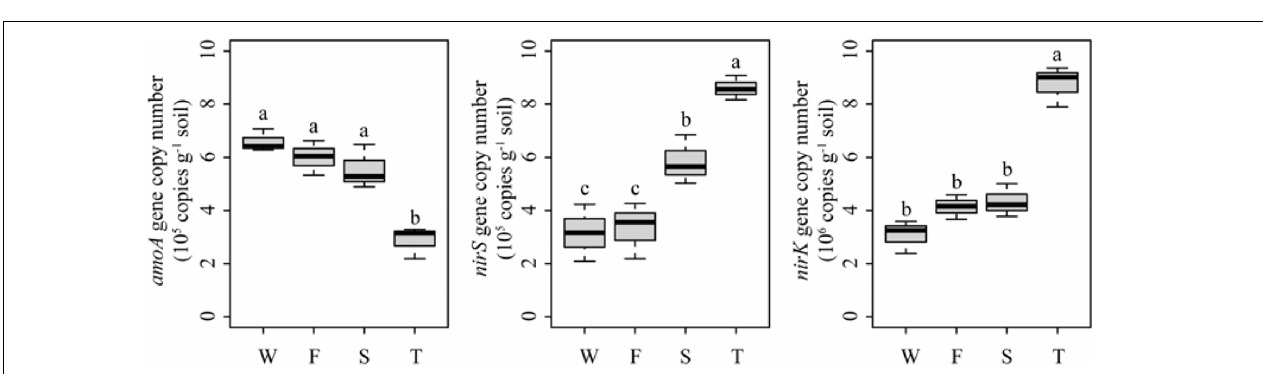
FIGURE 6 | Ordination plots of the results from the redundancy analysis. (A) Relationship between soil bacterial community structures at the OTU level (97% sequence similarity) with soil chemical properties. (B) Relationship between soil bacterial function profiles at KEGG level 3 with soil chemical properties. W represents the wheat field; F, S, and T represent the first, second, and third cropping of Jerusalem artichoke (JA), respectively.